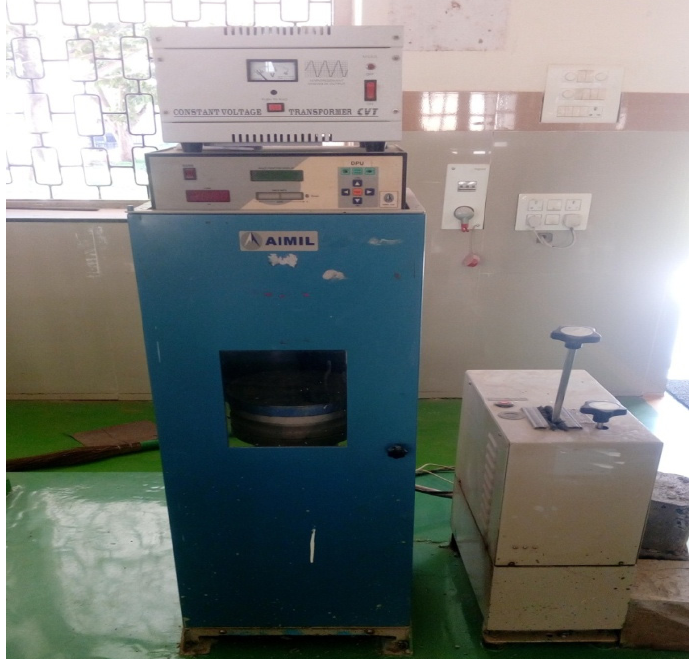
Figure 4. Equipment used for compression test.